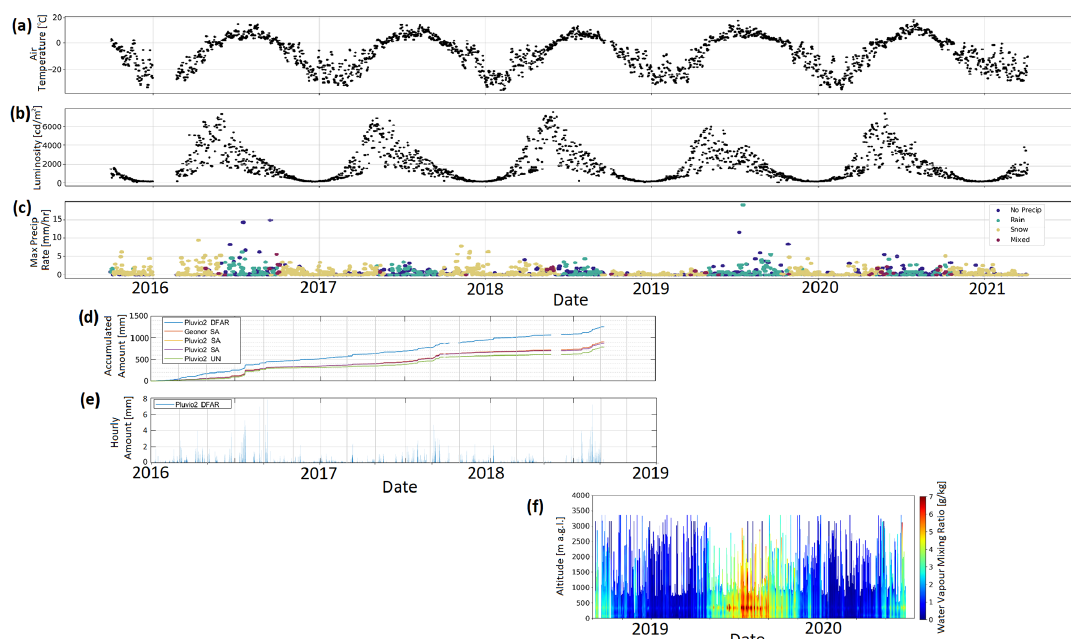
Figure 4. Surface meteorological observations conducted at the Iqaluit supersite from 29 September 2015 to 1 April 2021. PWD52 daily averaged air temperature (a) , luminosity (b) , and daily maximum precipitation rate and type (c) are shown for the entire period. Note that mixed precipitation type represents precipitation that is not rain or snow (e.g., freezing rain, sleet). The C-SPICE’s multiple Pluvio2s (DFAR, SA, and UN configurations) and Geonor accumulated precipitation amount (d) and hourly precipitation amount (DFAR Pluvio2 shown only) (e) are shown from 1 January 2016 to September 2018, when the C-SPICE project ended. Daily averaged water vapour mixing ratio profiles observed by the DIAL (f) are shown from the date of its deployment (14 September 2018) until 20 June 2020, when the instrument required